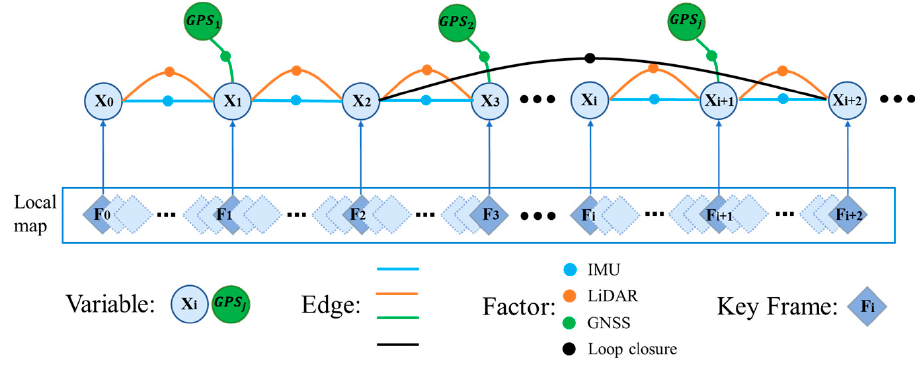
Figure 1. The factor graph adopted by our scheme.